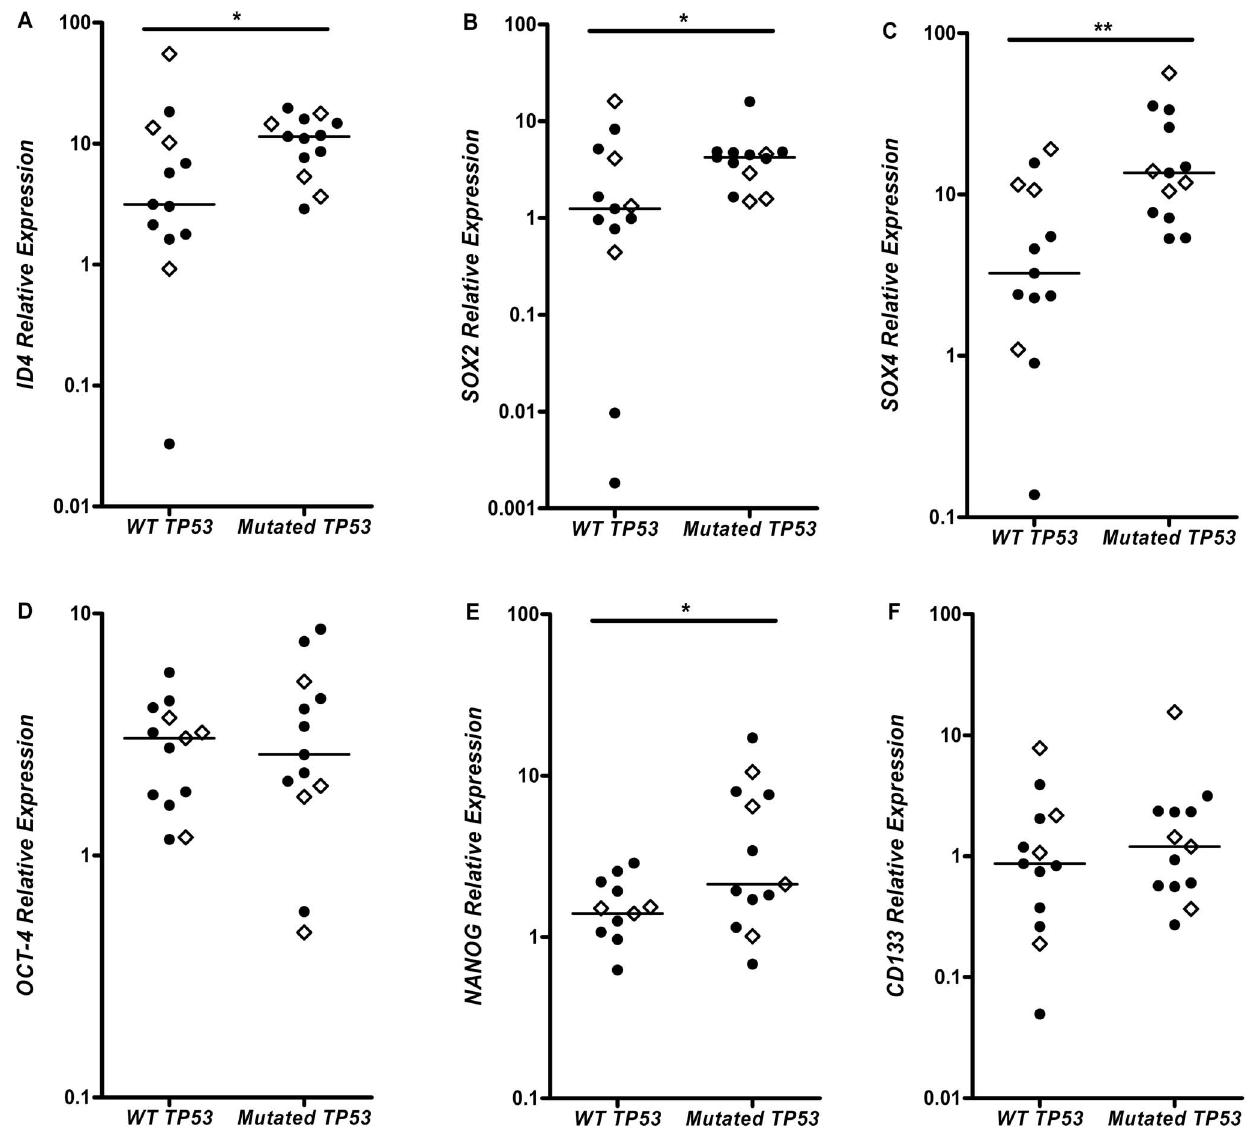
Figure 3. Comparison of gene expression levels between the wild-type TP53 ( WTTP53 ) and the mutated TP53 ( MutatedTP53 ) in AGII cases. Higher expressions of ID4 (A), SOX2 (B), SOX4 (C) and NANOG (E) were observed on the mutated TP53 AGII cases. No difference was found for OCT-4 (D) and CD133 (F) relative expression between the two groups. White lozenges represent the deceased patients. The p values are: * p , 0.05 and ** p , 0.005, Mann-Whitney